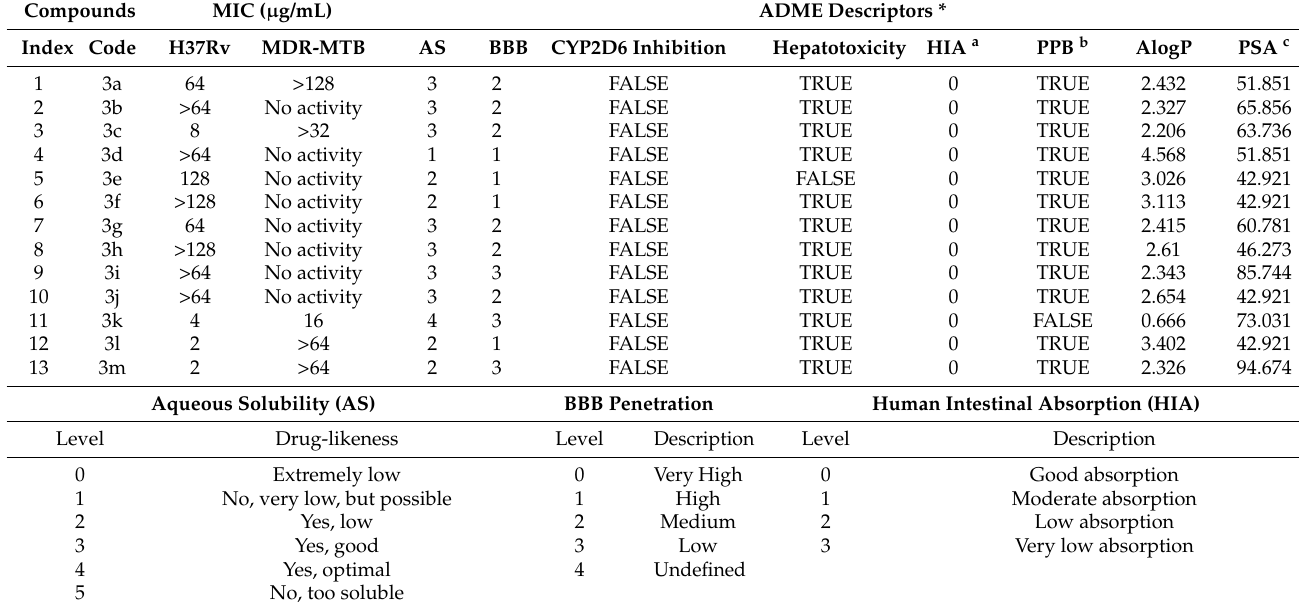
Table 3. Calculated ADME descriptors.